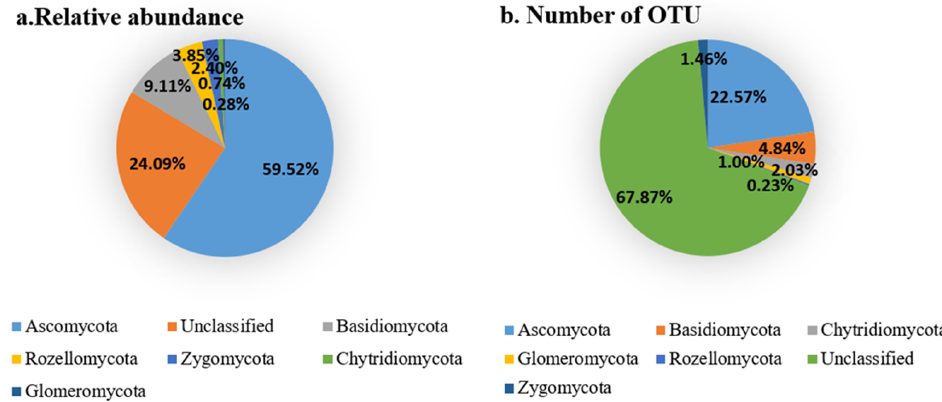
Figure 4. The relative abundance and OTU composition of soil fungi in the study area.